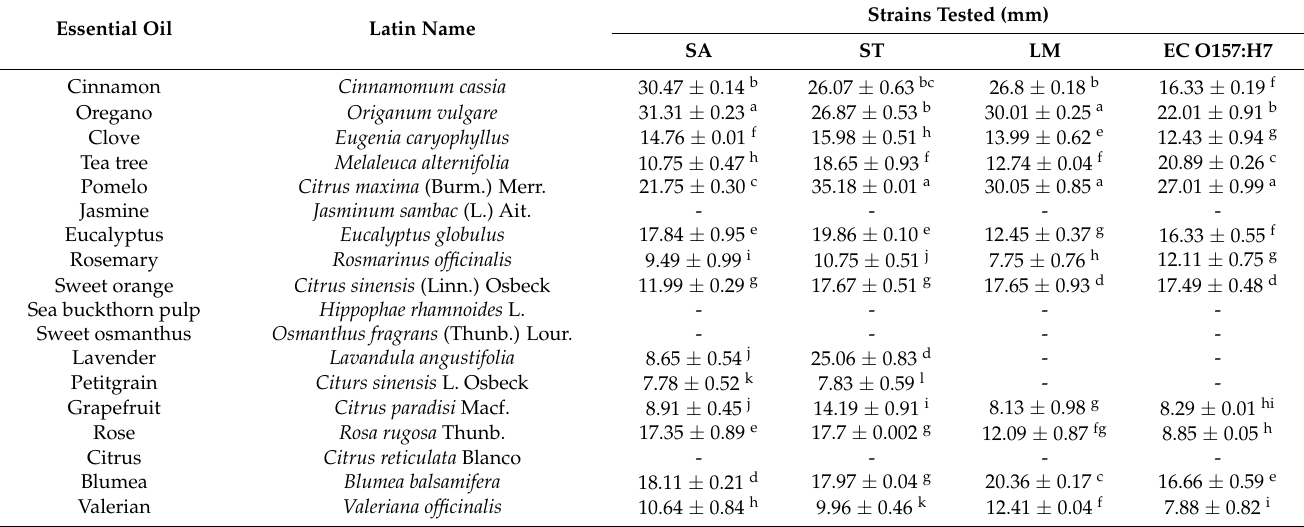
Table 1. Diameter (mm) of inhibition zones of essential oils against the four pathogenic